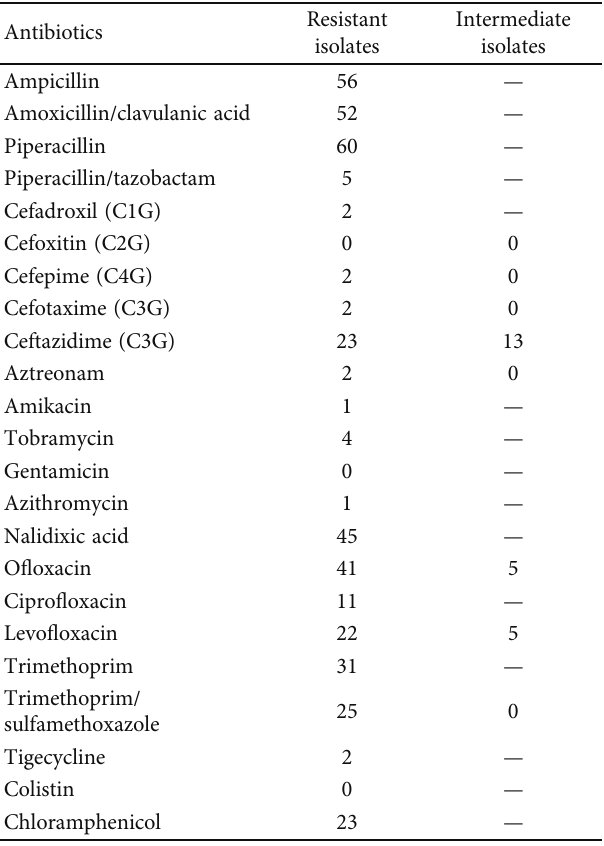
Table 2: Number of E. coli isolates resistant/intermediate for each tested